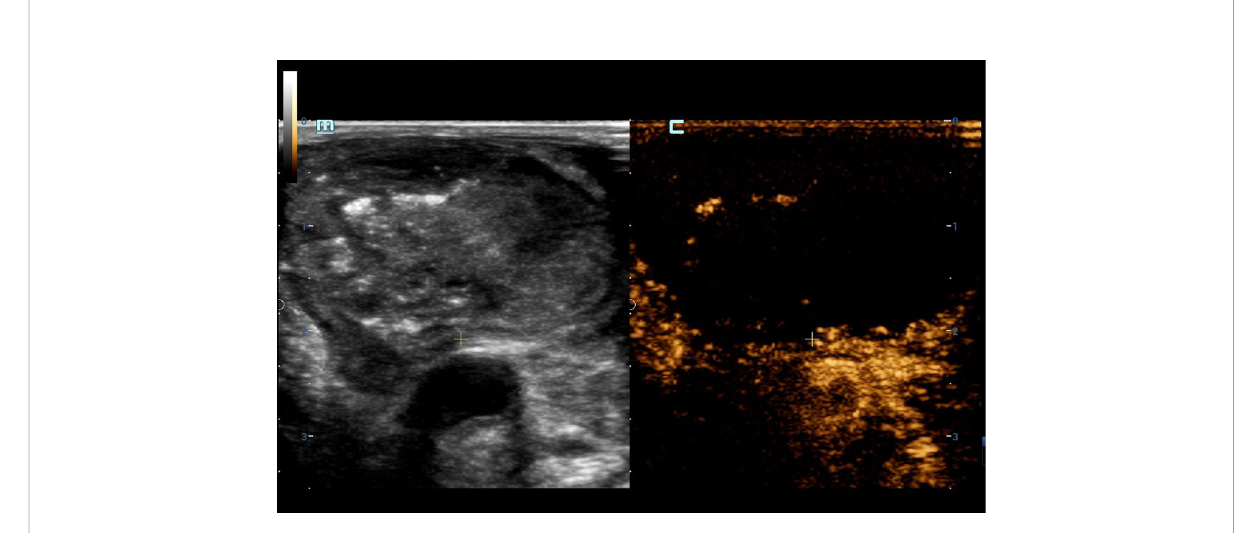
FIGURE 2 No contrast enhancement in left cervical mass according to postoperative